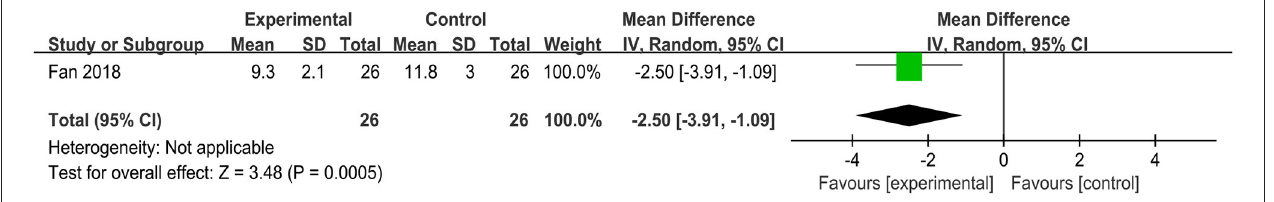
FIGURE 7 | Meta-analysis and forest plot for the length of hospital